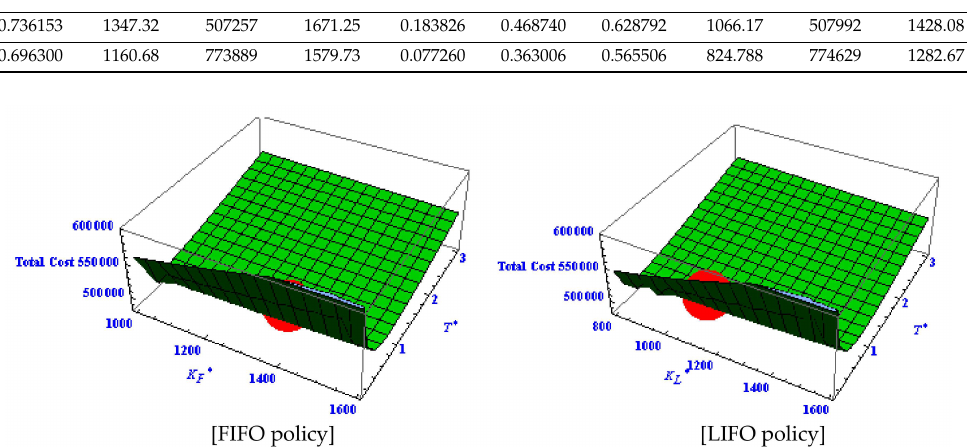
Figure 6. Graphical representation of convexity of a total cost function for FIFO and.